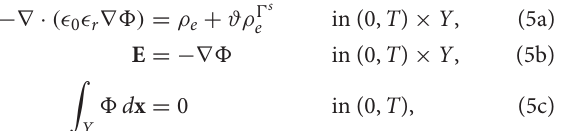
with the inverse solubility constant of Henry’s law H Ŵ LG r [ −